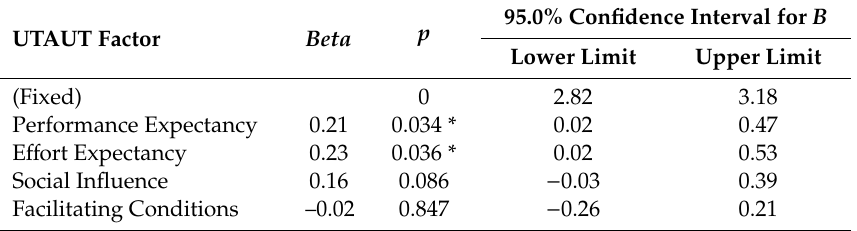
Table 3. Regression coe ffi cients—impact of UTAUT factors on e-prescribing frequency.